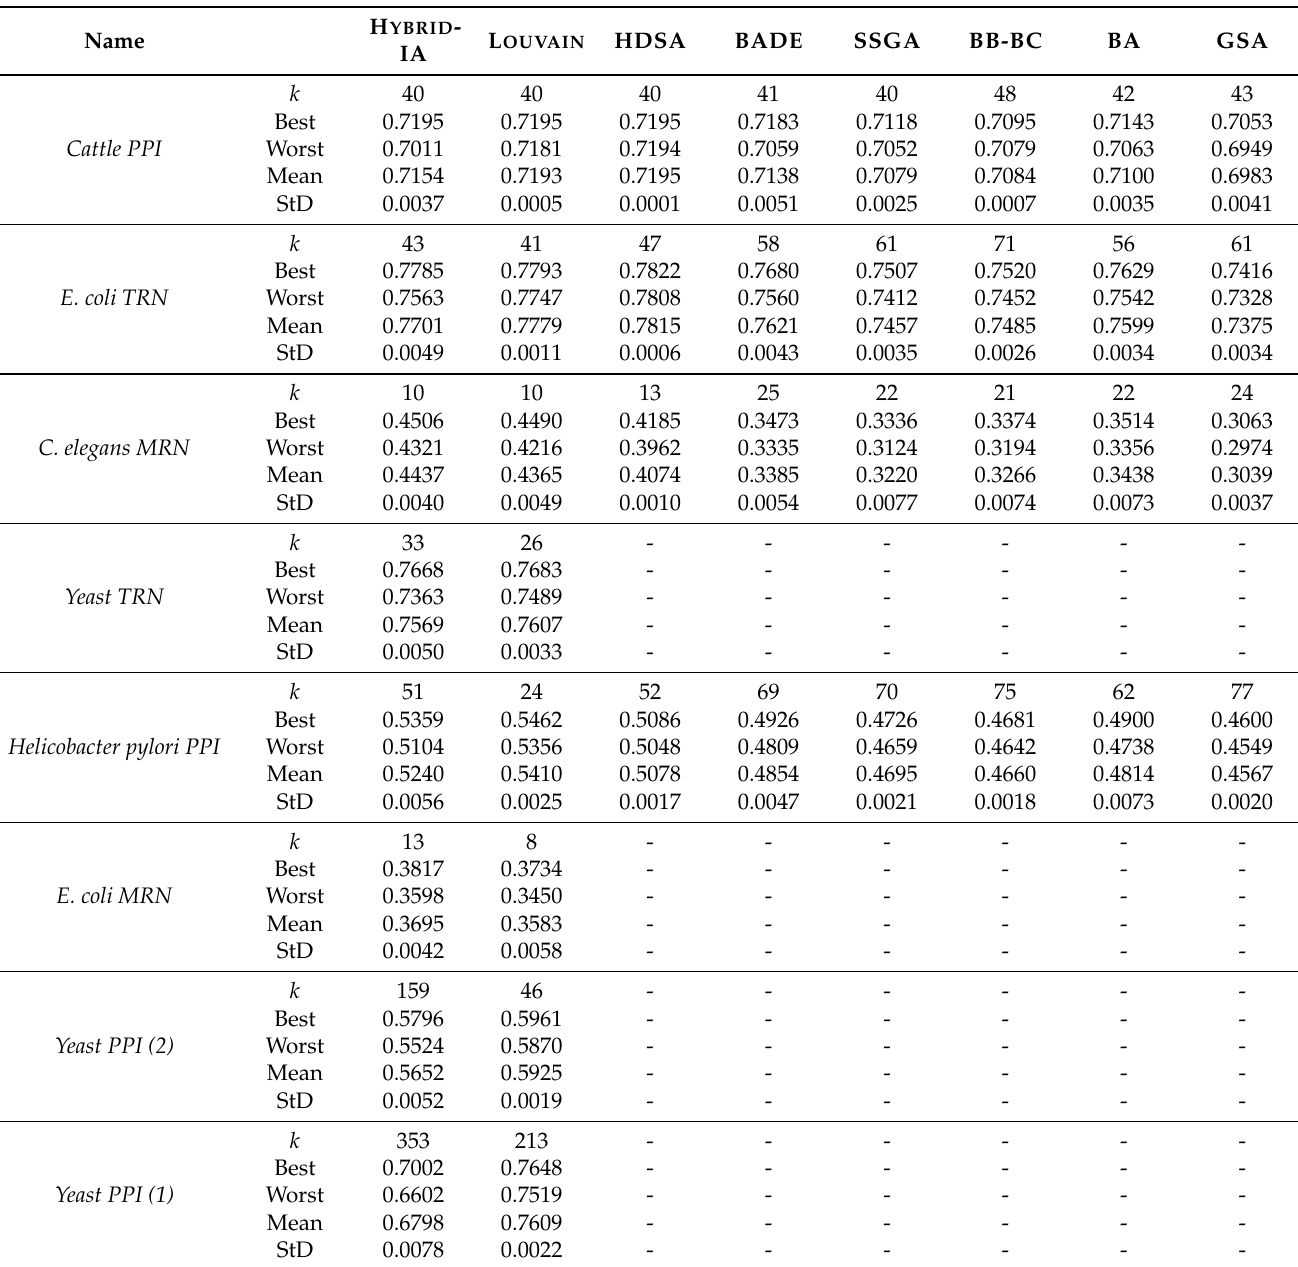
Table 2. Comparing the results obtained by H YBRID -IA on biological networks with the results obtained by other algorithms. The results are calculated over 100 independent runs for H YBRID -IA and L OUVAIN , while over 30 runs for the